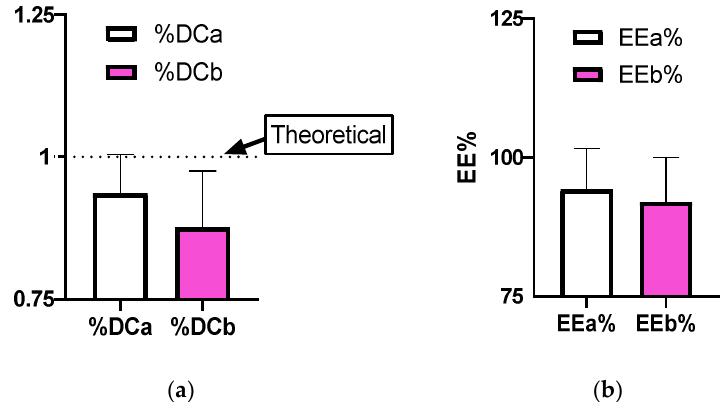
Figure 4. Representation of obtained results for aRB-PCL and bRB-PCL about ( a ) drug content (%DC); and ( b ) encapsulation efficiency (EE%).